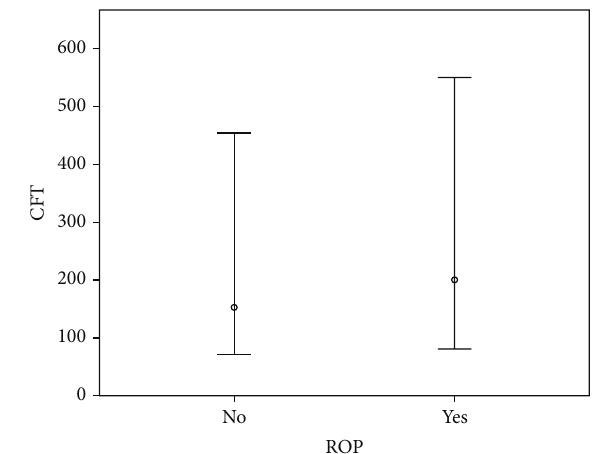
Figure 2: Comparisons of mean central foveal thickness (CFT) between the eyes with and without ROP. (ROP: retinopathy of